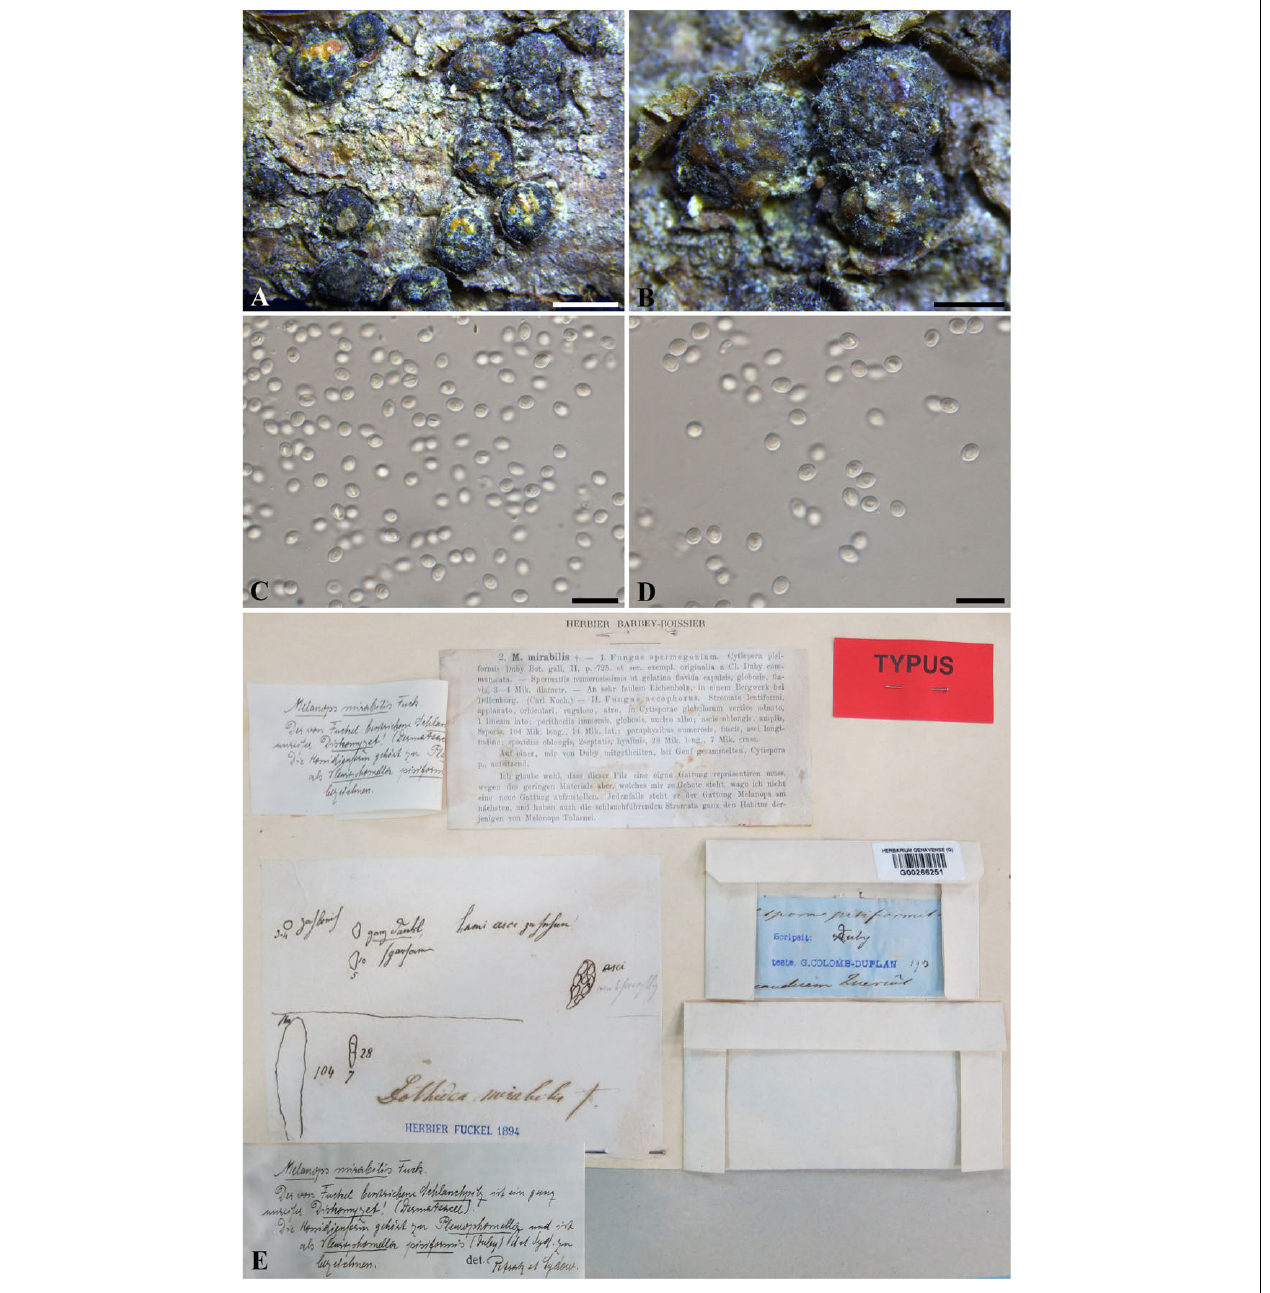
FIGURE 3 | Botryosphaeria mirabile (G 00266251, holotype ). (A,B) Fruiting bodies erumpent through the epidermis of twigs. (C,D) Spermatia produced in the fruiting bodies. (E) Herbarium label. Scale bars: (A) = 2 mm, (B) = 1 mm, (C,D) = 10 µ m.